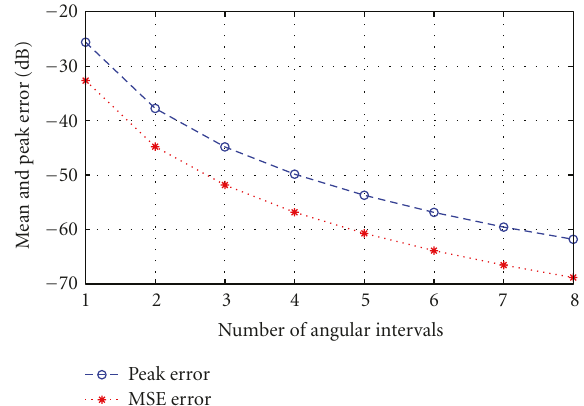
Figure 2: Mean squared and peak error ( ε k ) as a function of the number of angular intervals N .